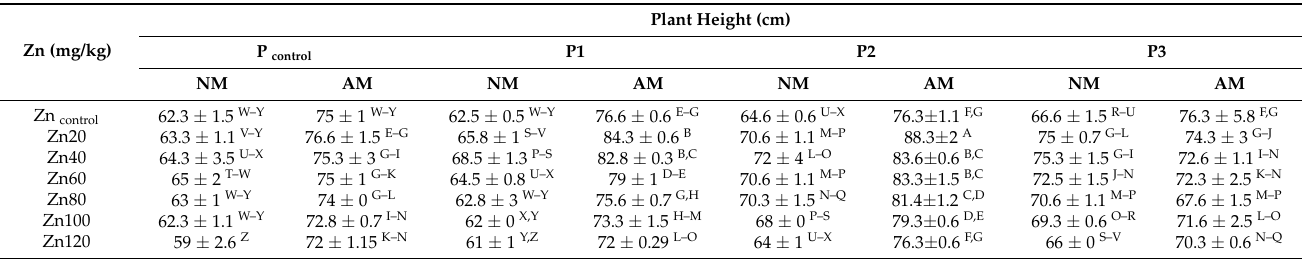
Table 3. Plant height (cm) and stem diameter (cm) of AMF inoculated (AM) and non-inoculated (NM) plants grown under various P (0 to full recommended dose) and Zn (0–120 mg Zn/kg soil) application rates.